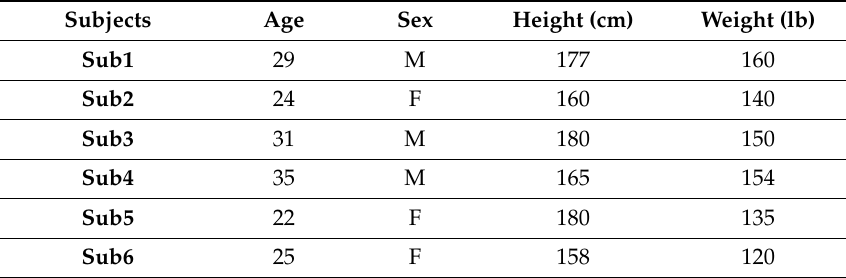
Table 1. Characteristics of the six human subjects tested in the